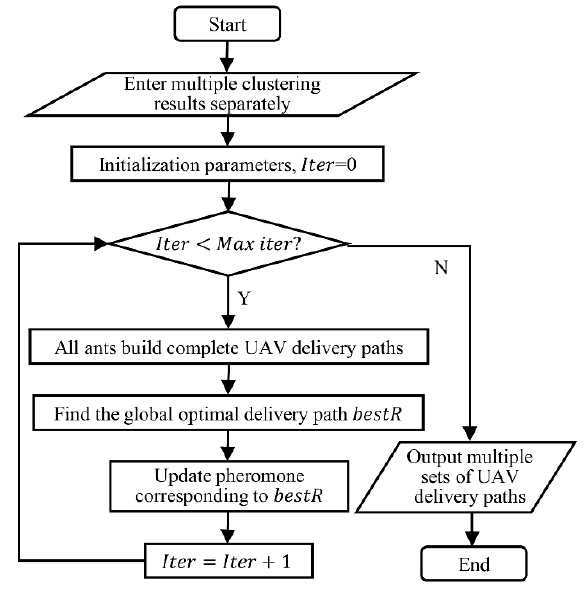
Figure 5. Improved ACO process.